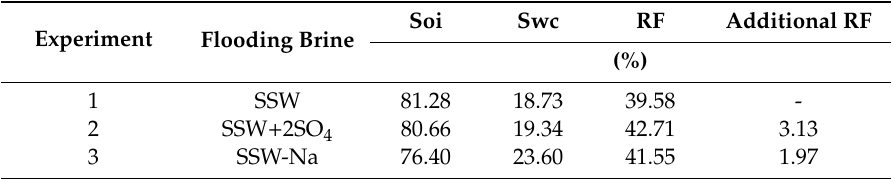
Table 10. Summary of artificial structure complex-wet micromodel with initial oil saturation, connate water saturation and final oil recovery factors.